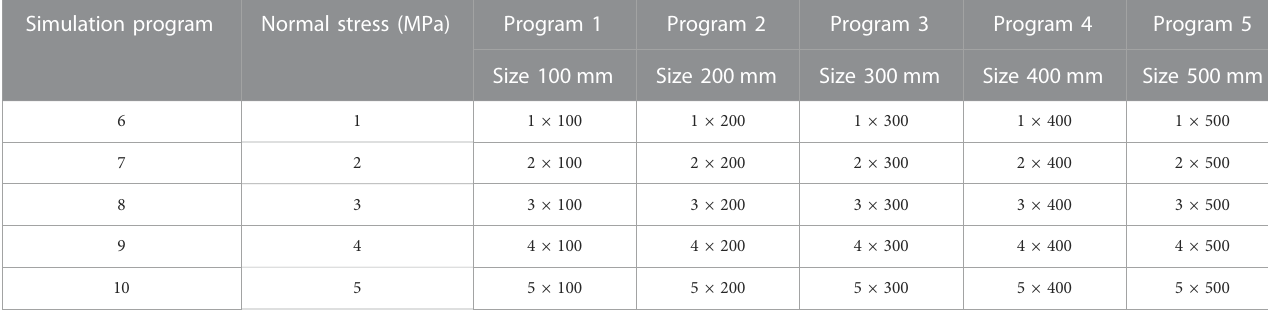
TABLE 1 Normal stress and size